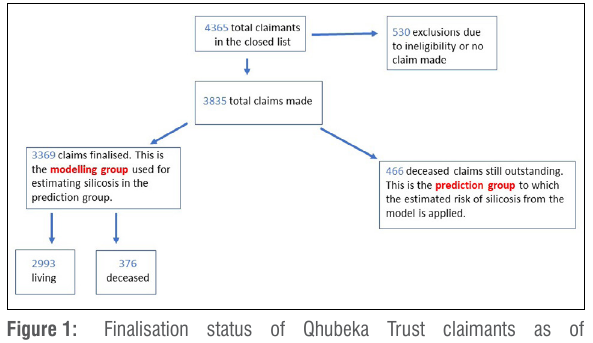
Figure 1: Finalisation status of Qhubeka Trust claimants as of 31 December 2019.